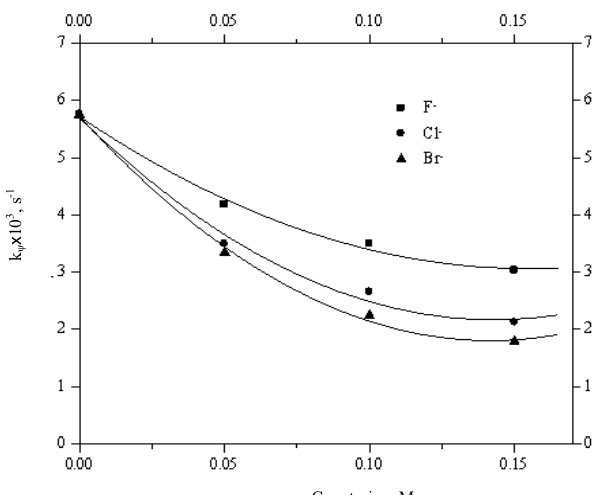
Figure 4. Effect of added counterions on the rate constant for CTAB catalysed reaction of RH + with OH -